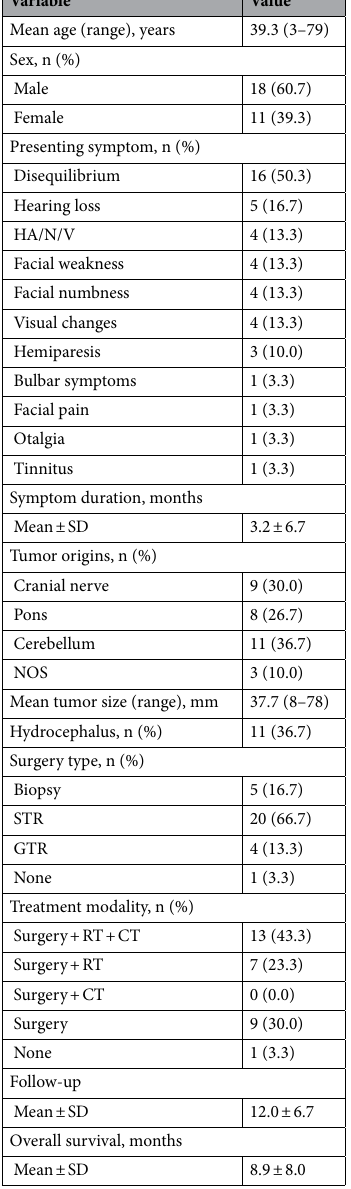
Table 1. Patient demographics and tumor